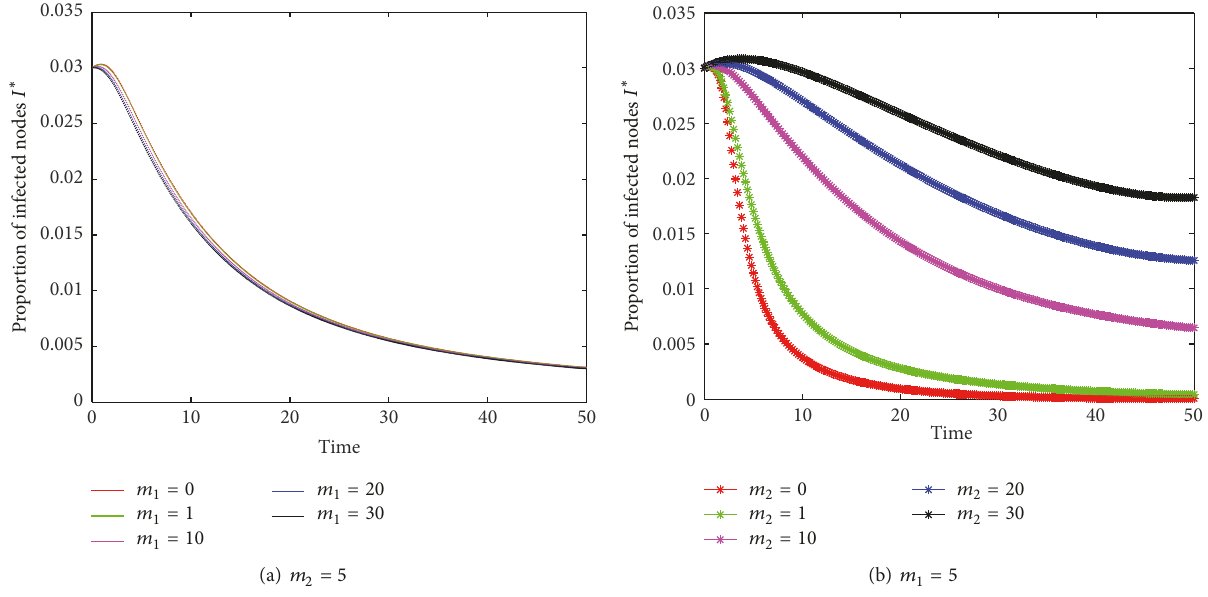
Figure 14: 𝐼 ∗ (𝑡) for different 𝑚 1 and 𝑚 2 for Example 3.